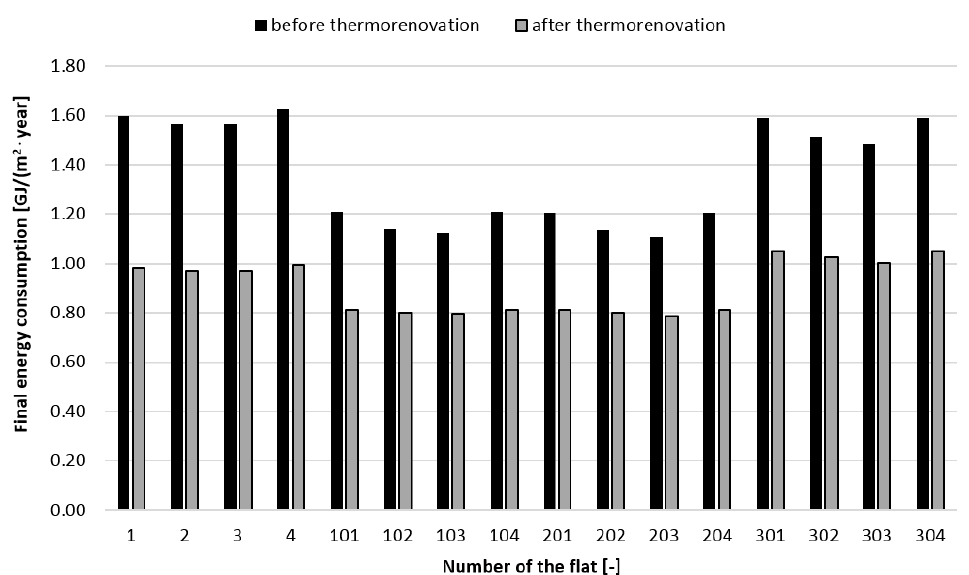
Figure 2. Unit maximum final energy consumption in the individual apartments of the analyzed building before and after thermorenovation.